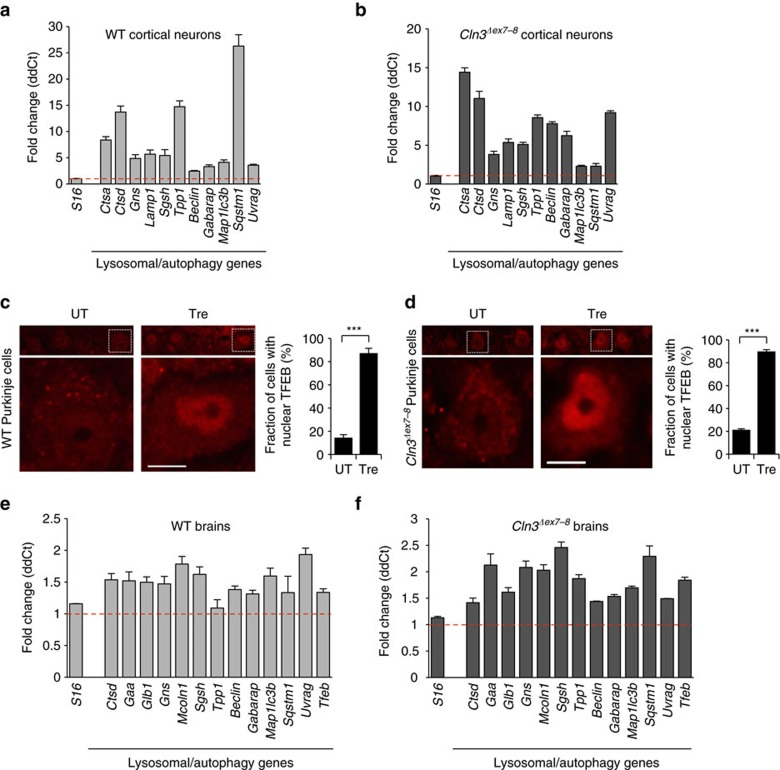
TFEB nuclear translocation and CLEAR network activation in vivo.(a,b) Expression analysis of cultured cortical neurons from WT (a) and Cln3Δex7-8 embryos (b) at E17.5 shows transcriptional activation of lysosomal genes on trehalose administration. (c,d) Confocal microscopy of brain sections from WT (c) and Cln3Δex7-8 (d) mice shows prevalent nuclear distribution of TFEB in Purkinje of treated mice. C and N in bar diagram indicate cytosolic and nuclear distributions, respectively. Scale bar, 20 μm. (e,f) Expression analysis of brain homogenates from WT (e) and Cln3Δex7-8 (f) mice on trehalose administration compared to untreated mice, showing transcriptional activation of lysosomal genes. Gene expression was normalized relative to the housekeeping gene, S16. The red dashed line indicates relative gene expression in untreated mice. Data represent means±s.e.m.